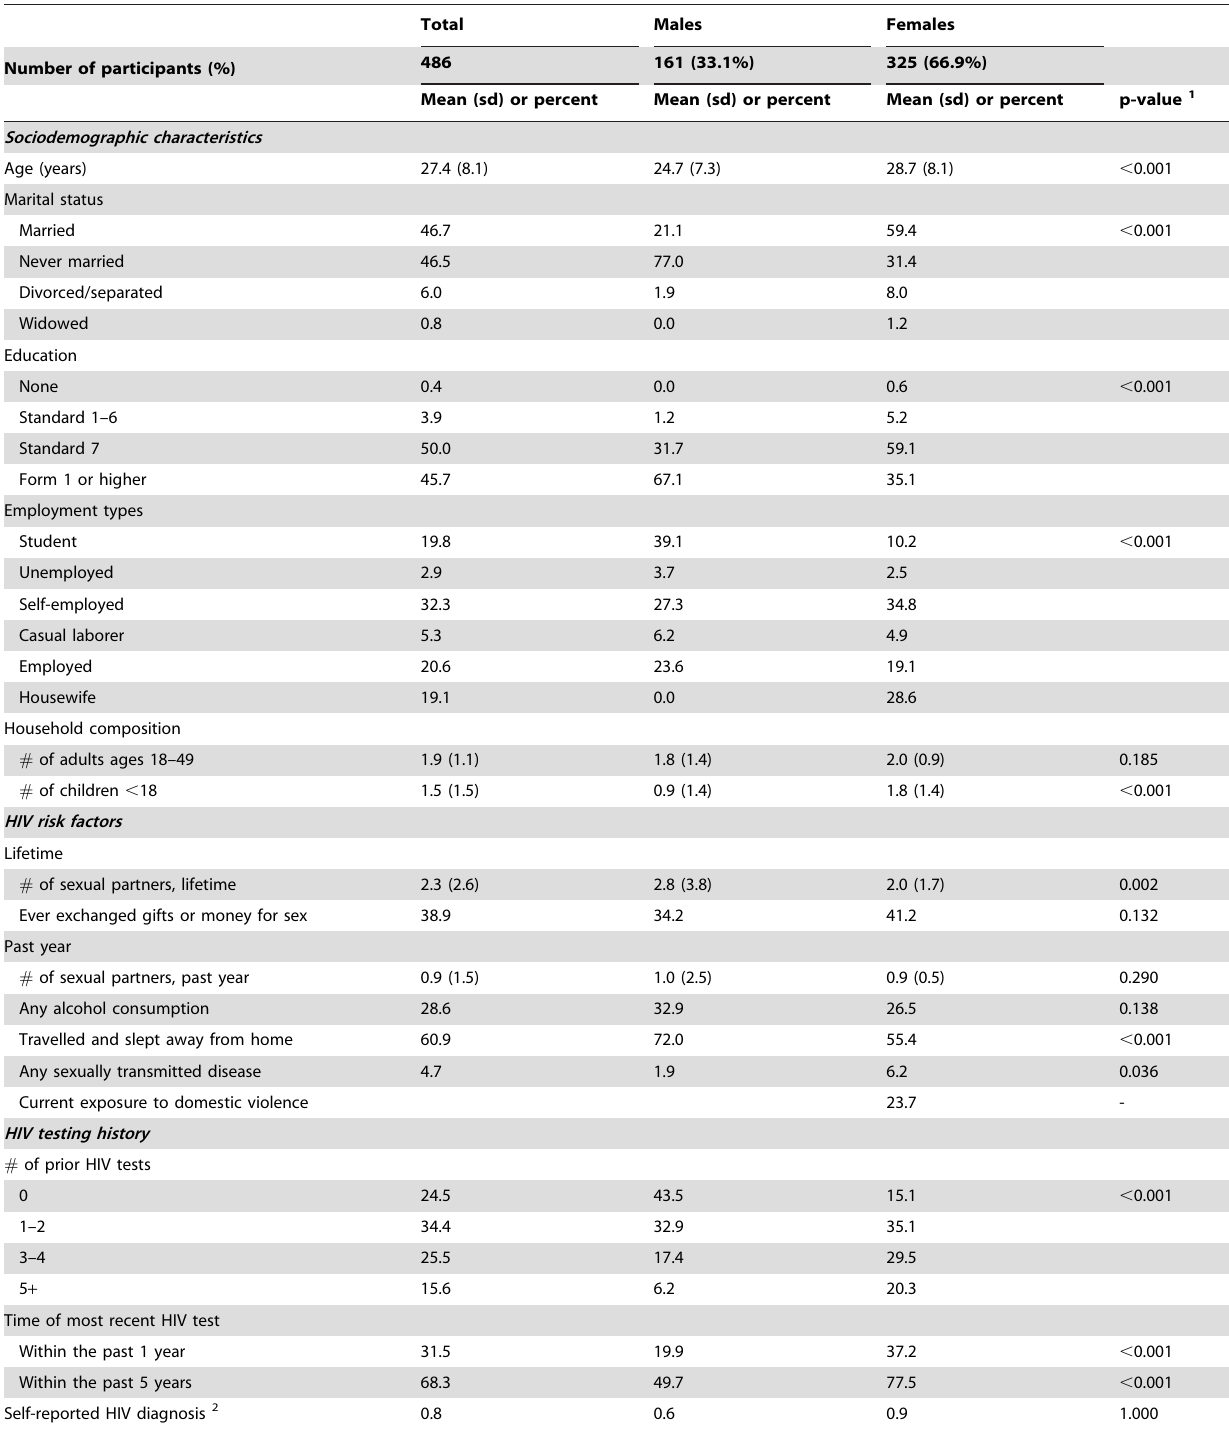
Total Males Females